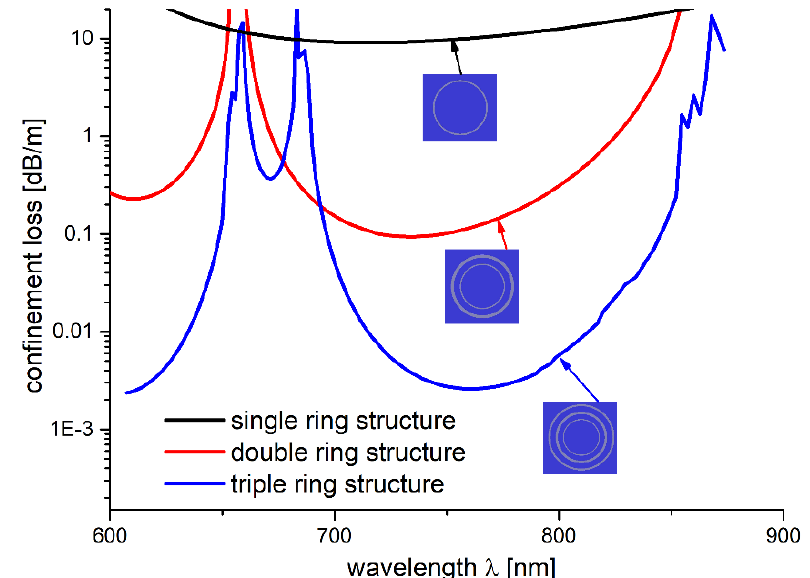
Figure 9. Confinement loss of the single- (black line), double- (red line), and triple- (blue line) ring structure. The innermost ring represents the capillary walls of the star structure, while rings 2 and 3 are a representation of the star structure’s strut. To reflect the strut’s different dimensions, rings 2 and 3 have their thicknesses set to 0.98 and 1.24 µm, which corresponds to the strut’s width (dimension a ) and height (dimension b ), respectively. The appearance of three confinement loss peaks (for the triple ring structure), at the resonant wavelengths of ~650, ~690, and ~860 nm, is visible. This peaks correspond to the previously modeled CL of the star structure.